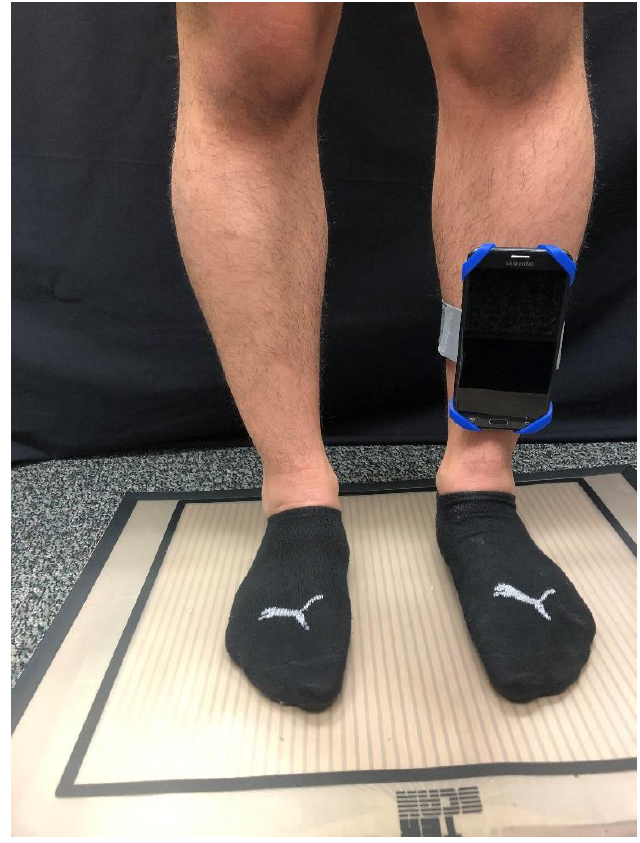
Figure 1. Subject standing on the force plate with the smartphone attached to the left tibia during data acquisition.